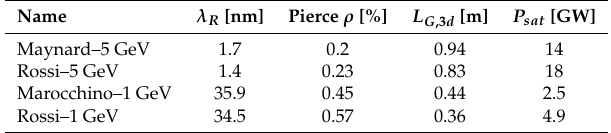
Table 6. FEL semi-analytical results based on the best slice parameters of Table 3.